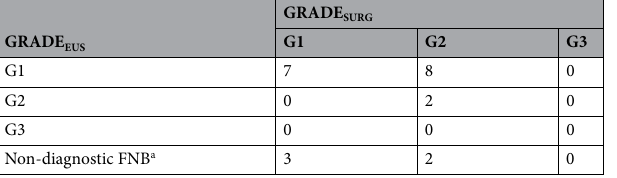
Table 4. The tumor grade of resected PanNETs (n = 22) as assessed in EUS-FNB samples (GRADE EUS ) and in the corresponding surgical specimens (GRADE SURG ). a EUS-FNB samples being non-diagnostic at pathology including